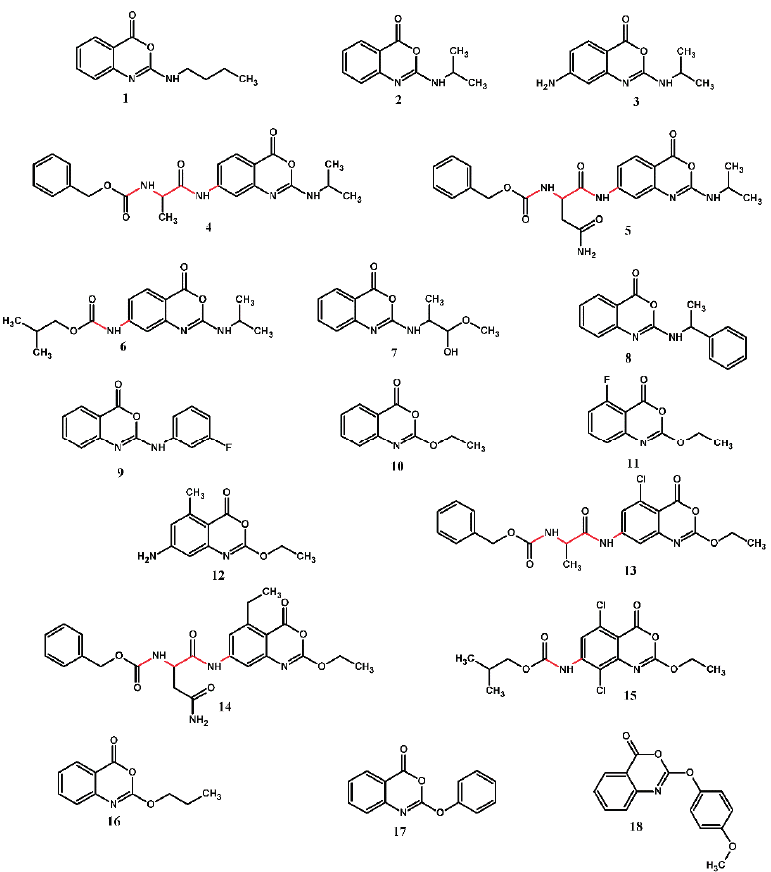
Figure 2. Chemical structures of the benzoxazinone derivative series. Peptidic portions of the backbone (highlighted in red) were treated as rigid bonds.